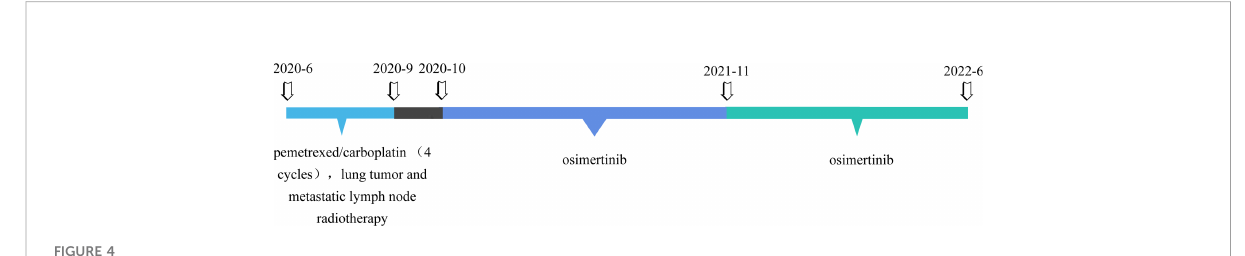
FIGURE 4 Timeline of the interventions and outcomes.